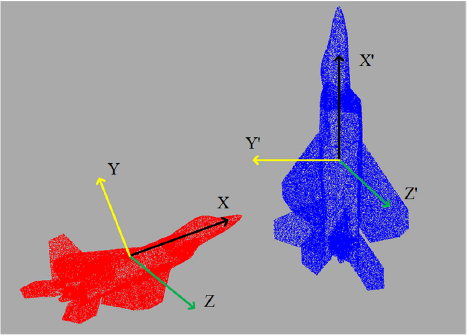
Figure 4. Original point cloud and point cloud after PCA principal direction correction.